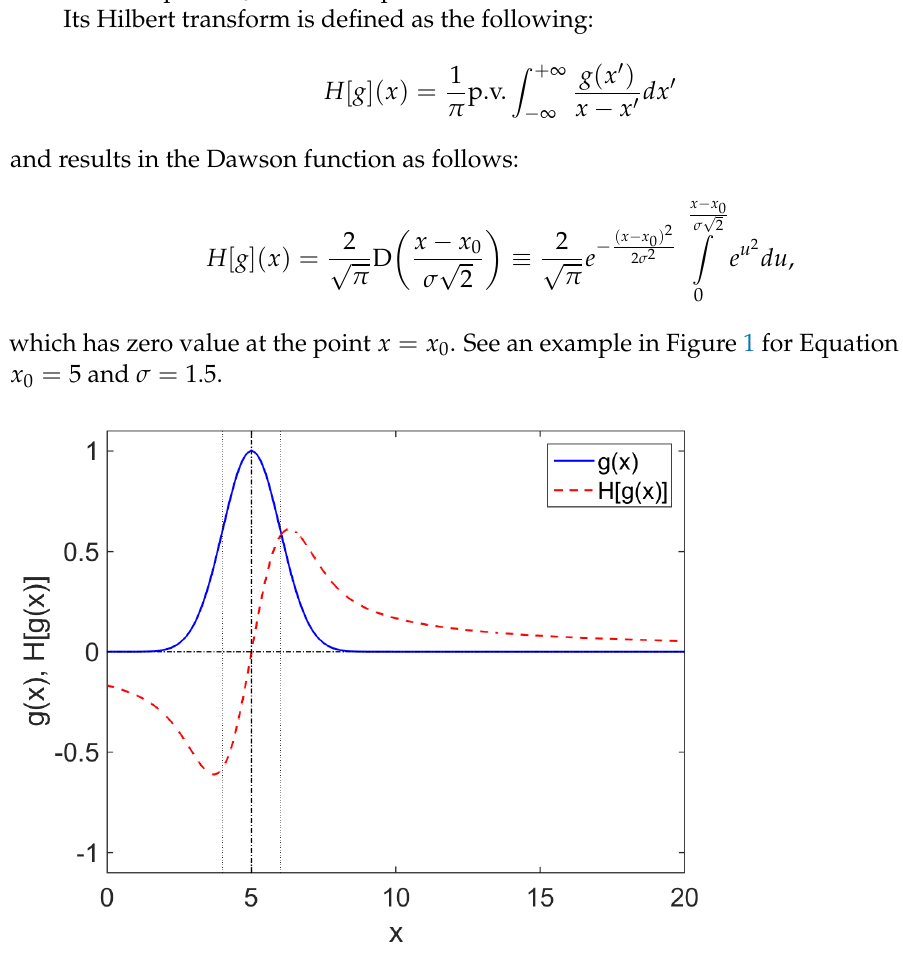
Figure 1. The Gaussian function and its Hilbert transform. The vertical dotted lines bound the interval [ x 0 − σ , x 0 + σ ]